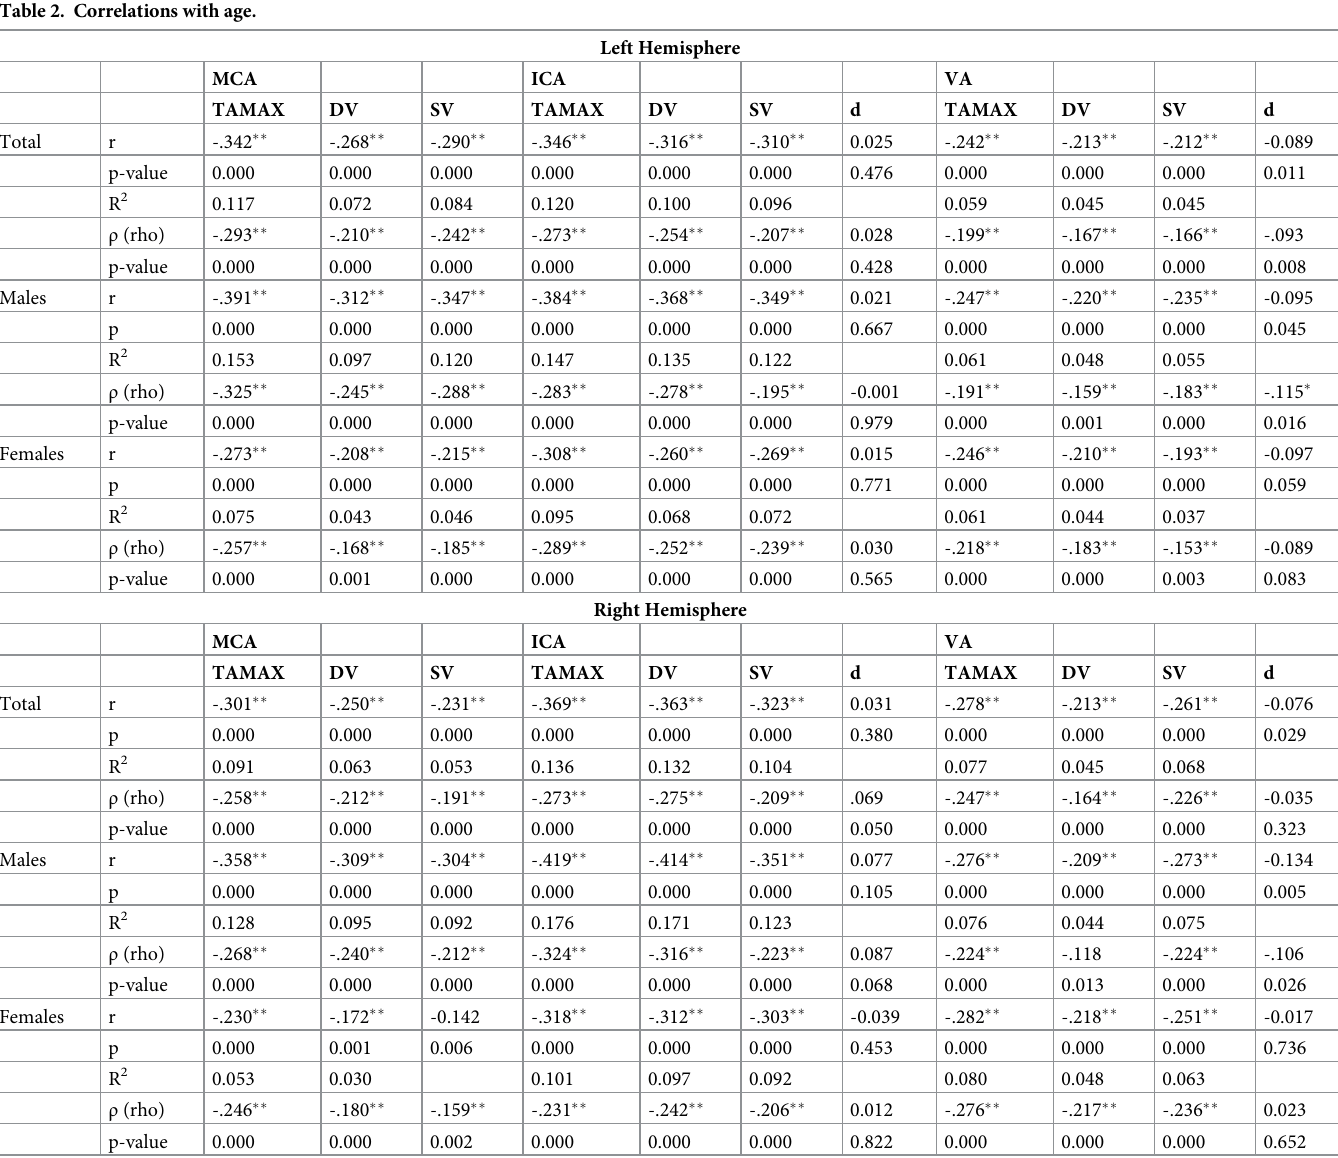
Table 2. Correlations with